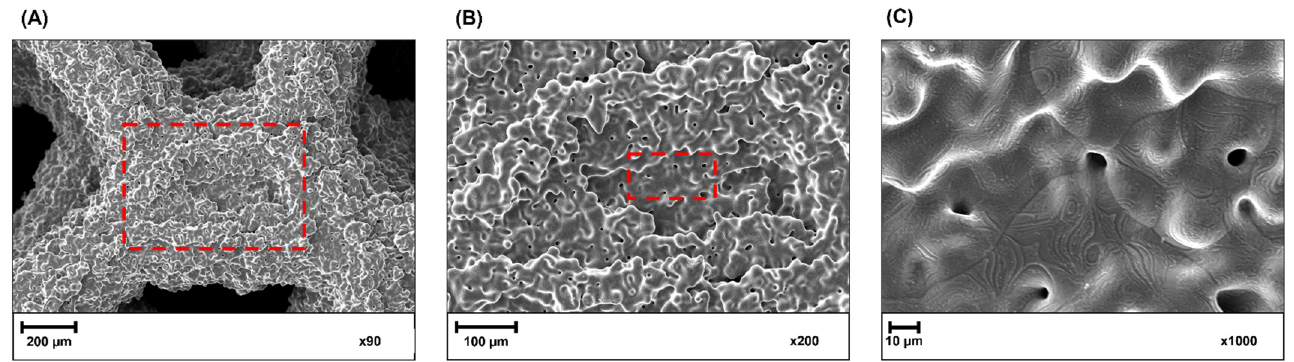
Figure 9. The SEM (JEOL JSM-6610LV) images of DLC coatings deposited on Voronoi structure with magnification ( A ) ×90, ( B ) ×200, and ( C ) ×1000.